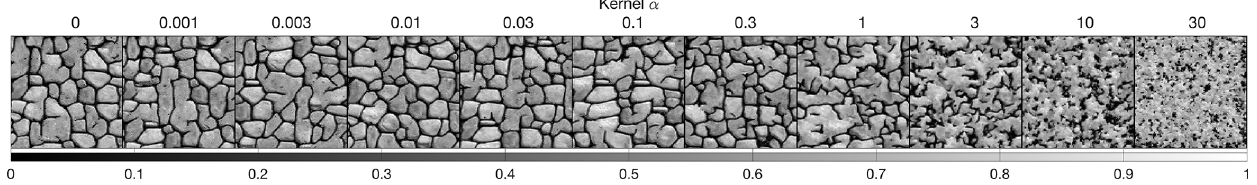
Figure A5. Complete sensitivity analysis, with one simulation for each kernel with k = 1 . 5 and N = 40.